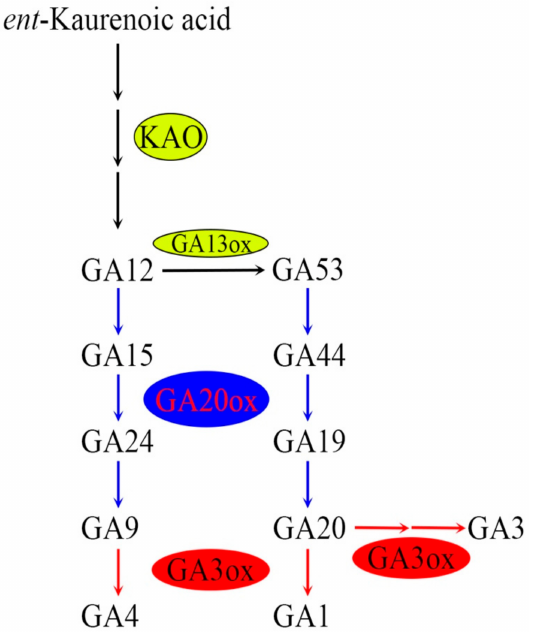
Figure 2. Gibberellin biosynthesis pathway related to gibberellin oxidase. The ent-Kaurenoic acid is converted to GA12 by ent-kaurenoic acid oxidase (KAO) in the endoplasmic reticulum. GA12 is converted into GA53 by GA13ox, and both GA12 and GA53 are converted into GA9 and GA20, respectively, by GA20ox. GA3ox catalyzes the biosynthesis pathway from GA9 and GA20 into bioactive GA1, GA3 and GA4,